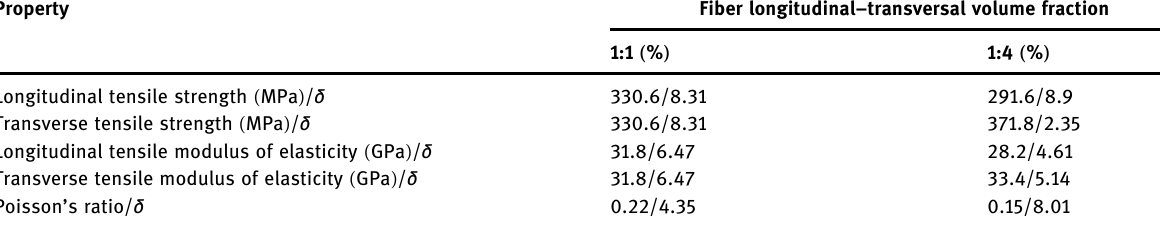
Table 1: Mechanical properties of GFRP